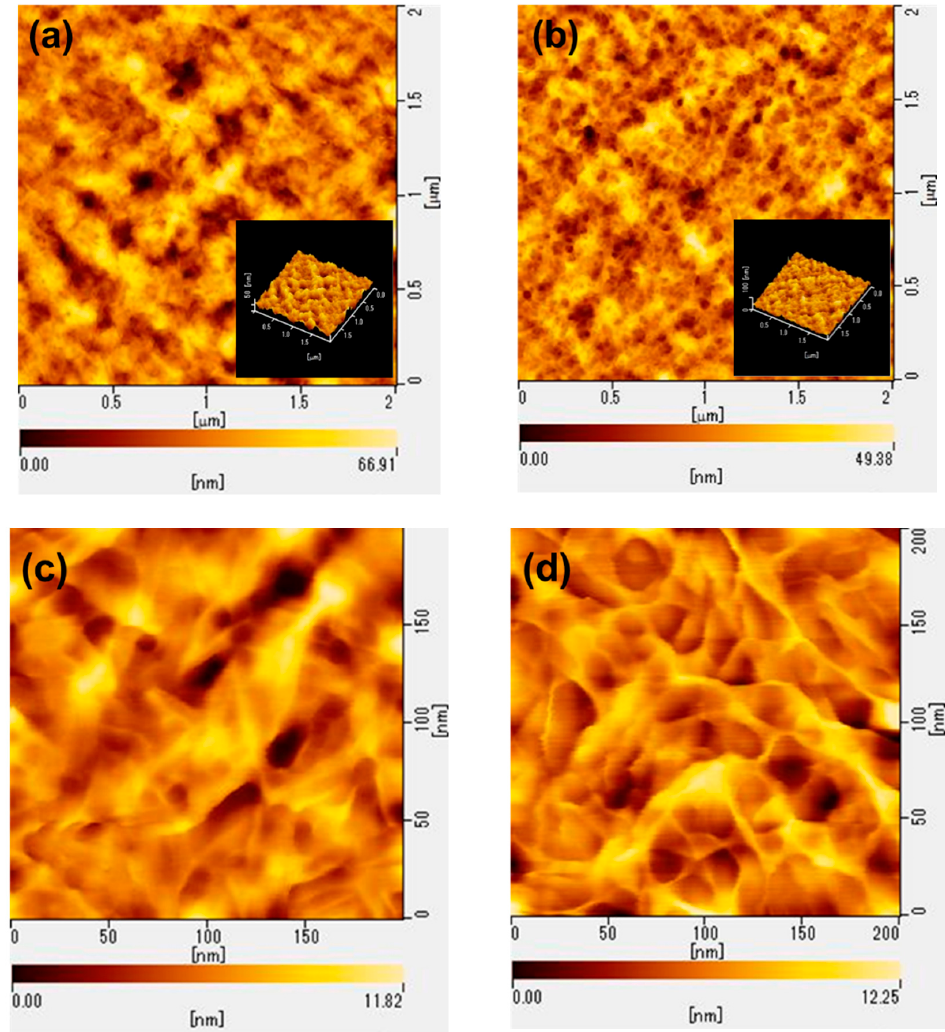
Figure 8. AFM images of regenerated cellulose films prepared from CNF through coagulation with ( a , c ) 5 wt% H 2 SO 4 and 5 wt% Na 2 SO 4 aqueous solution, ( b , d ) methanol.